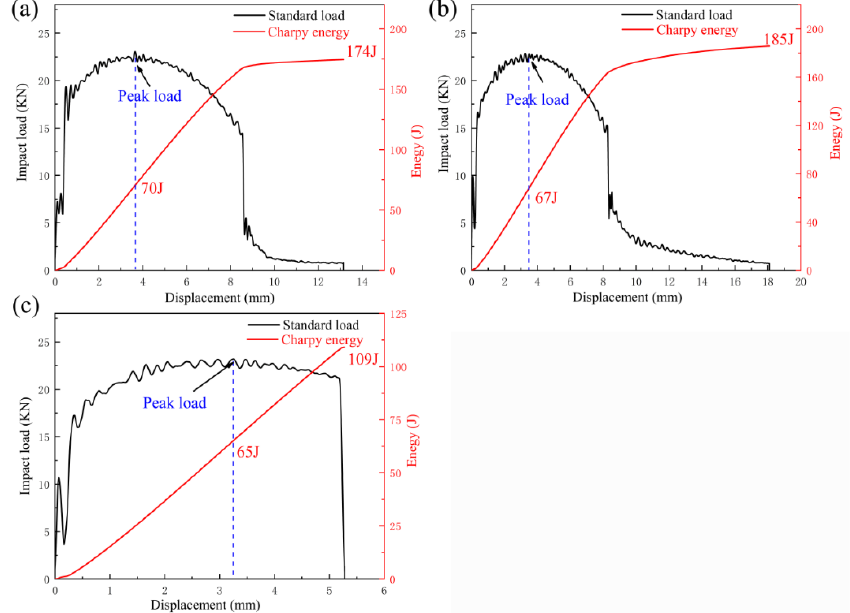
Figure 6. The impact load and impact absorption energy curves versus the displacement obtained from instrumented impact experiments at −60 °C: ( a ) S1, ( b ) S2, and ( c ) S3. Table 3. Comparison of crack initiation energy and crack propagation energy of the X80 × D1422 mm heavy-wall heat- induced seamless bend. Samples